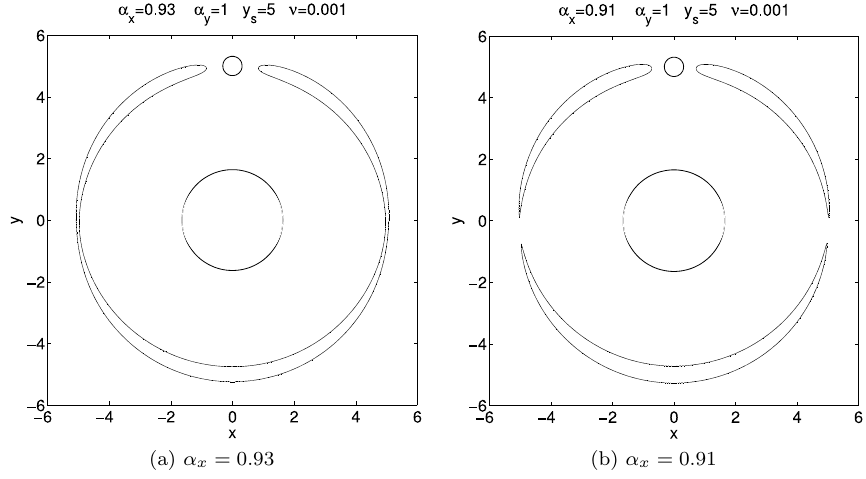
Fig. 5. Zero velocity curves for a value of C = (cid:0) 0 . 30011 for the binary systems ν = 0 . 001, ⃗r = (0 , 5 , 0) and α y = 1. In Figure 5a, α x = 0 . 93, and the zero velocity curve has a horseshoe shape. In Figure 5b, α x = 0 . 91 and the zero velocity curve has opened up at the Lagrange points L 6 and L 7